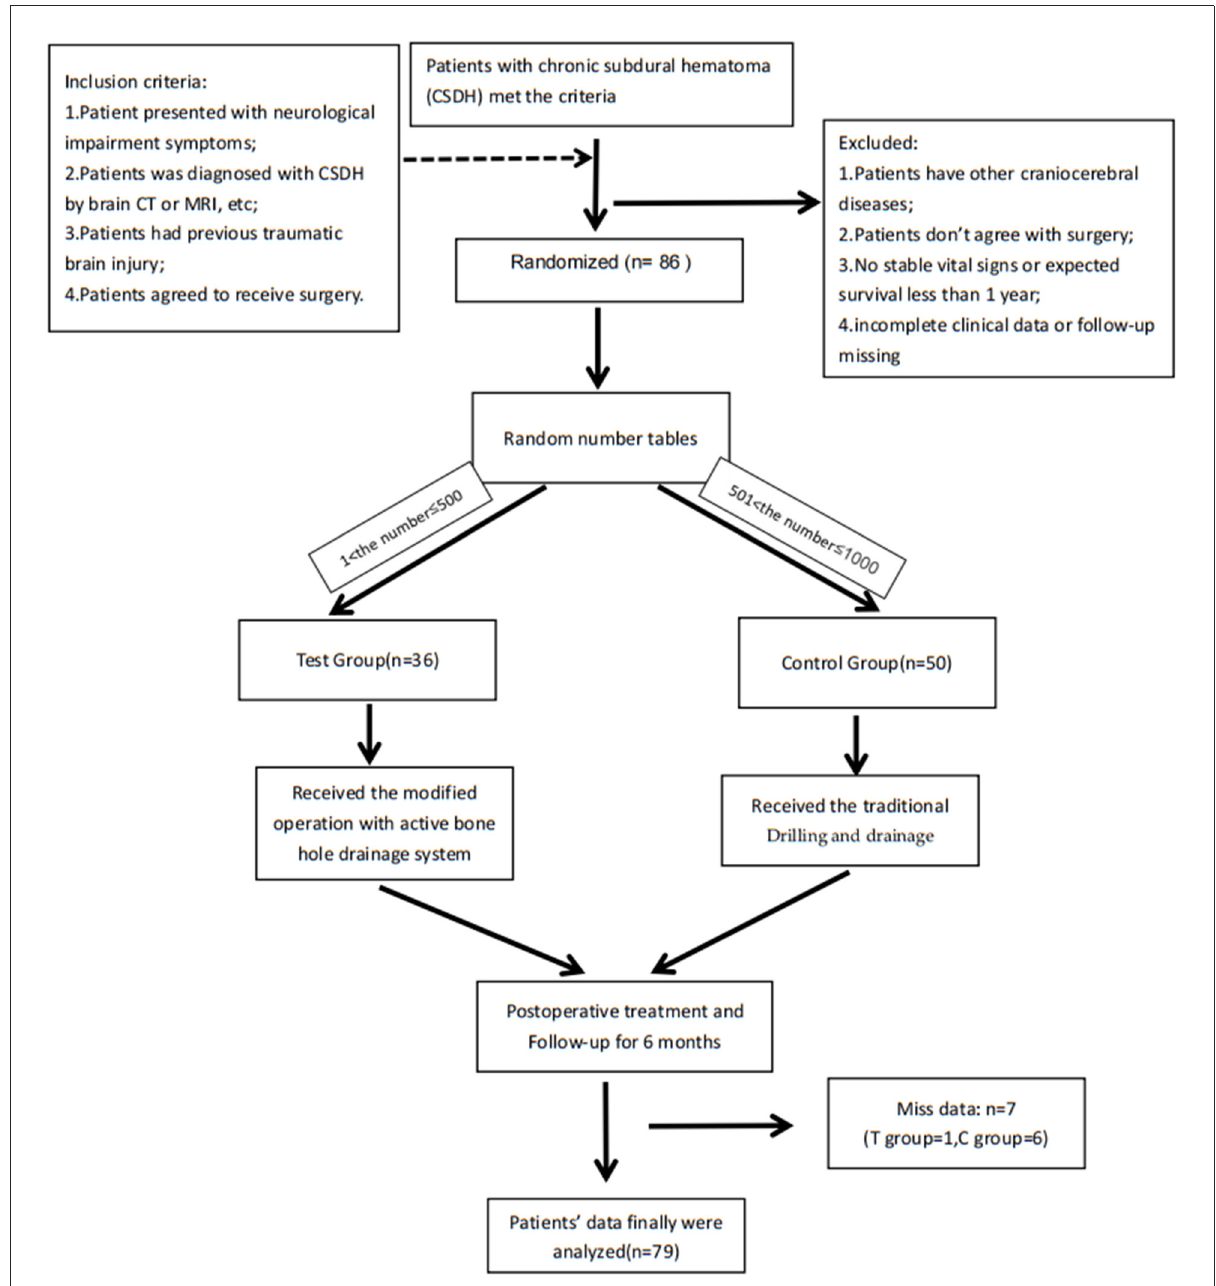
FIGURE2 Flow chart of the whole research: Patients were randomly assigned by random number tables: the C language-rand () function randomly generates a number between 1 and 1,000, they were assigned to the control group (received the traditional surgery) when 1 < number ≤ 500 and they were assigned to the test group (received the modified surgery) when 501 < number ≤ 1,000. After the operation, residents took over post-operative care. The residents and patients did not know the group assignment and surgery conditions other than surgeons, while surgeons didn’t participate in the treatment and didn’t know the patients’ hospitalization information. Only the project manager had all the information. This study was registered with the Chinese Clinical Trials Register